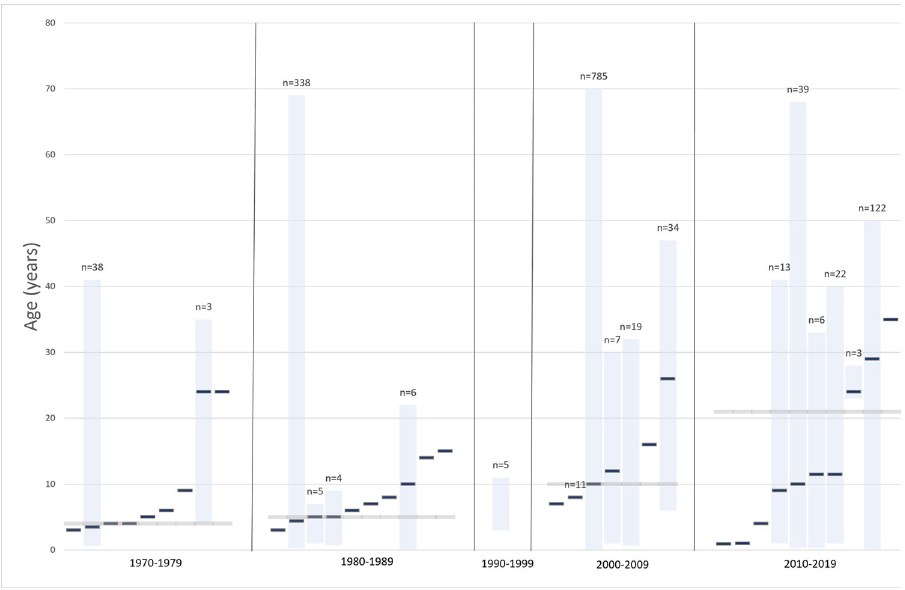
Fig 9. Median age and range of confirmed, probable and/or possible monkeypox cases in Africa per decade. Blue bars without range refer to the age of a single case. The grey horizontal line represents the weighted median. No data on median ages could be retrieved for the